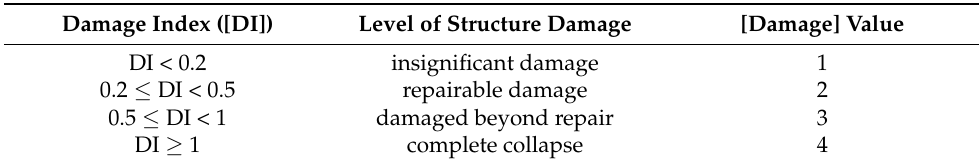
Table 1. The damage indices and associated levels of structure damage [33]. The four values in the last column are used in the implementations and